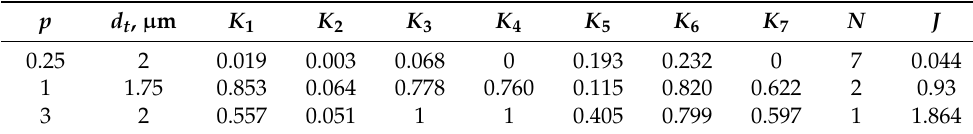
Table 1. Values of K 1 – K 7 criteria and J = J ( d t , p ) for selected prototypes.